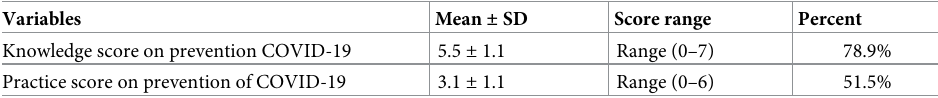
Table 4. The knowledge and practice score of the respondents towards COVID-19 pandemic prevention (N = 341).